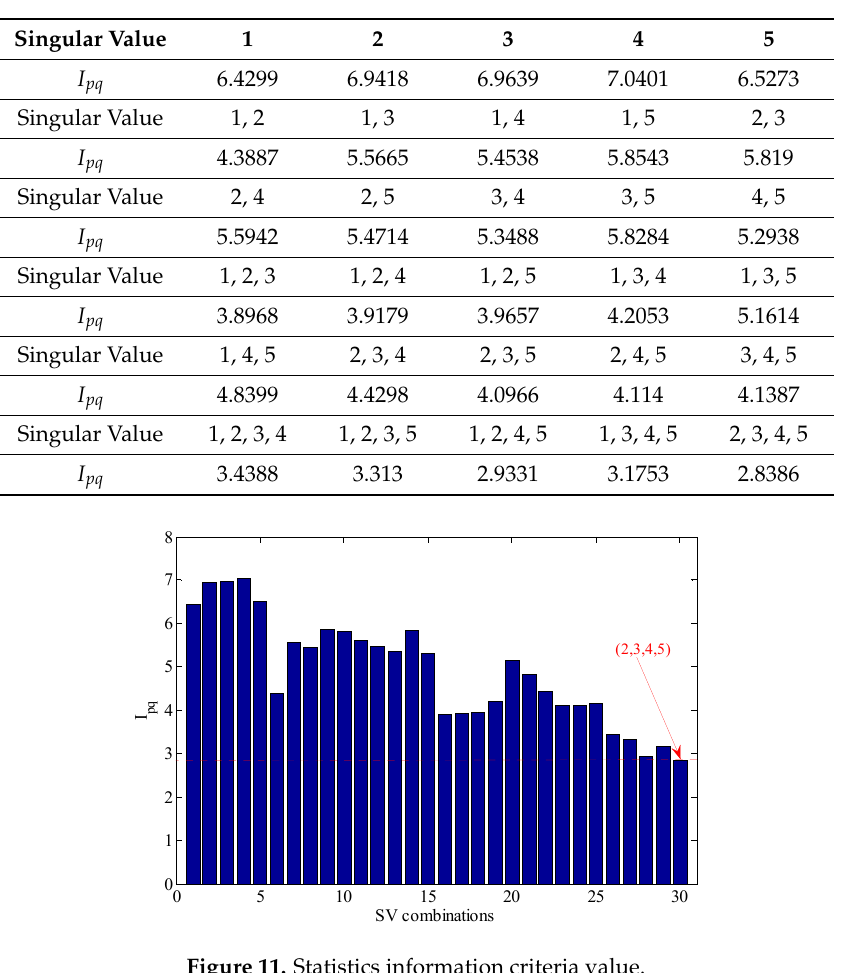
Table 3. Statistics information criteria value.